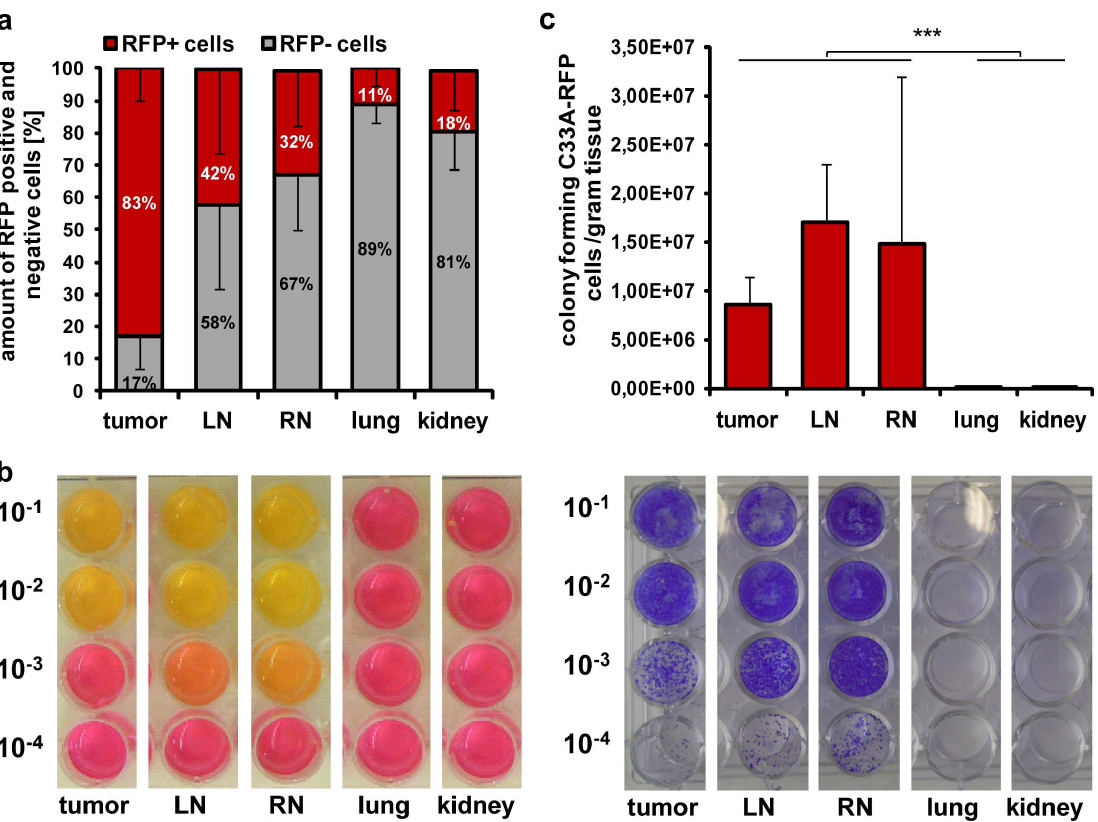
Figure 5. Analysis of tumor, LN, RN, lung and kidney single cell suspensions from C33A-RFP tumor-bearing mice 49 dpti. Tissues of all 5 mice were analyzed (n=5). a Amount of RFP positive (RFP + ) and negative (RFP-) cells in single cell suspensions of tumor, LN, RN, lung and kidneys. 10,000 events were analyzed by FACS. b Growth of different dilutions (10 2 1 –10 2 4 ) of C33A-RFP single cell suspensions in wells of 24-well plates after one week of blasticidin selection. Left image: media consumption in wells containing 2 days old media. Right image: wells after staining with crystal violet. c Numbers of colony forming C33A-RFP cells per gram tumor, LN, RN, lung and kidney, respectively. Cell colonies were counted for each organ after blasticidin-selection and crystal violet staining.